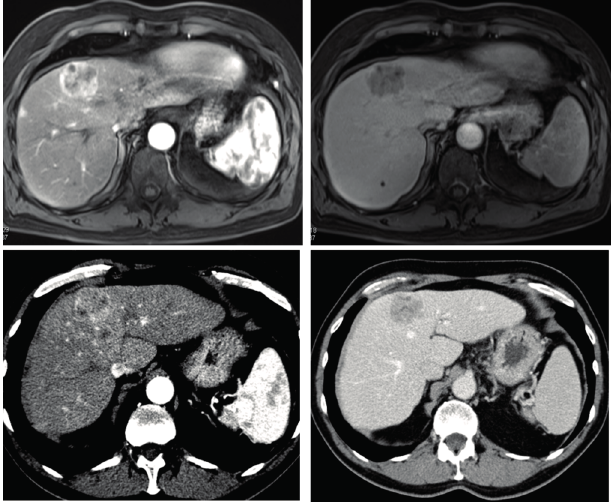
Figure 1. Radiological hallmarks of hepatocellular carcinoma (HCC). Typical vascular pattern of HCC as observed in a 67-year old patient with histology proven HCC. Liver lesion in the right hepatic lobe observed in a cirrhotic patient. The lesion is presenting a typical HCC vascular pattern with arterial hyperenhancement ( left images ) and venous wash-out ( right images ) visible both in magnetic resonance imaging (MRI) ( upper row ) and computed tomography (CT) ( lower row